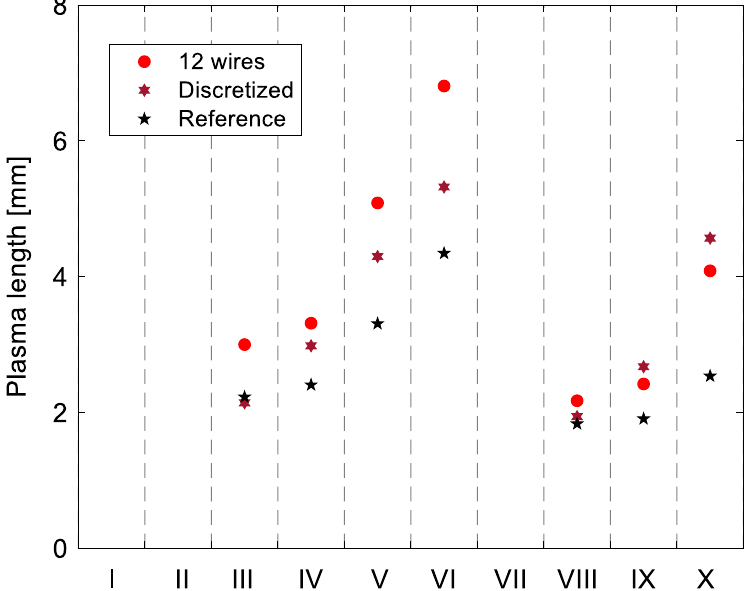
Figure 12. Variations in plasma length over 10 sections for the string-array-type PA with 12 wires ( V p-p = 20 kV, P PA = 115.6 W/m), and reference ( V p-p = 14 kV, P PA = 114.1 W/m) and discretized ( V p-p = 12 kV, P PA = 117.3 W/m) sheet-type PAs for P PA ≈ 115 W.